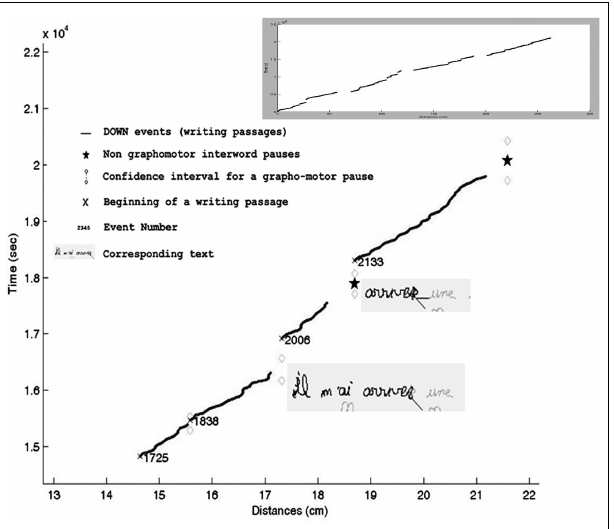
FIGURE 4 | Detail of the representation of the dynamics of a